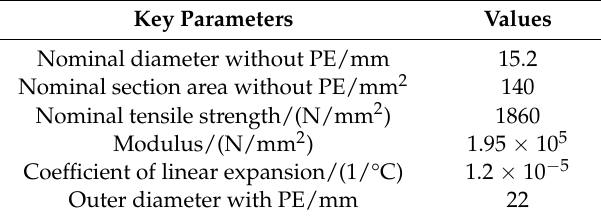
Figure 3. The structural drawing of steel strands: 1—Steel wires; 2—Polyethylene cables; 3—Grease. Table 2. Key parameters of the adopted strands.